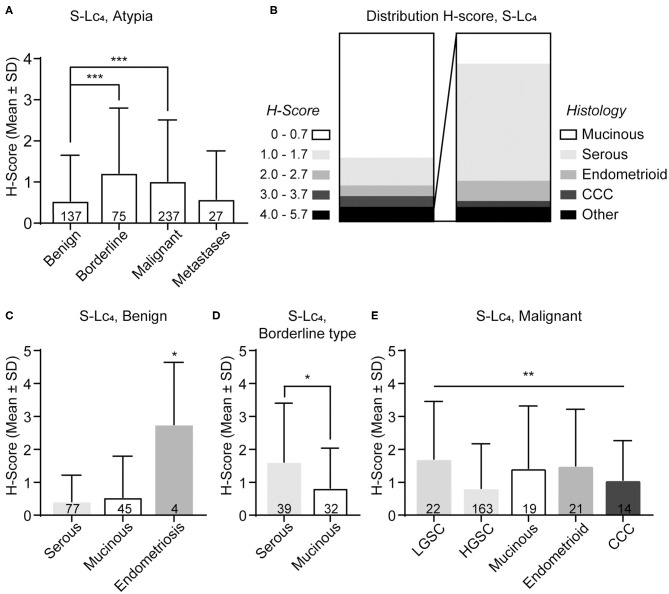
Distribution of S-Lc4 in epithelial ovarian tumors of different histologic subtypes. (A) Assessment of the S-Lc4 expression at different levels of malignancy. (B) Distribution of the level of S-Lc4 expression in the full data set (n = 478). Insertion demonstrate the histology distribution in tumors with high levels of S-Lc4 (n = 34). The level of S-Lc4 expression in different histology types compared per level of malignancy (C) Benign tumors, (D) Borderline type tumors, and (E) Malignant tumors. Data are presented as mean ± SD. P-values was determined with Mann-Whitney U-test or Kruskal-Wallis test, where applicable. Multiple comparisons was adjusted for by using Bonferroni correction. Significant p-values are denoted as; *p < 0.05, **p < 0.001, ***p < 0.0001. P-values represent pairwise significant data (A,C) or the Kruskal-Wallis test, when pairwise comparisons were not significant (E). Number of patients are indicated in the figure.